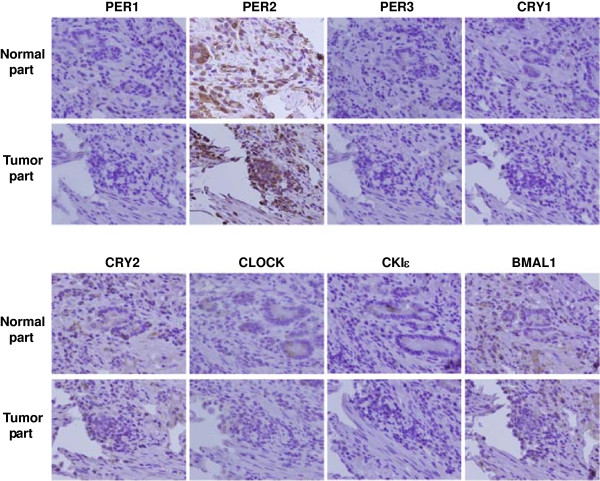
Immunohistochemical analyses of eight circadian clock genes in gastric cancer (GC). A representative case of GC shows higher expression of PER2 in cancerous tissues compared with that in adjacent noncancerous tissues. Expression of PER1, PER3, CRY1, CRY2, CLOCK, CKIϵ, and BMAL1 does not differ between cancerous and noncancerous tissues from GC patients. Original magnification: 400 × .